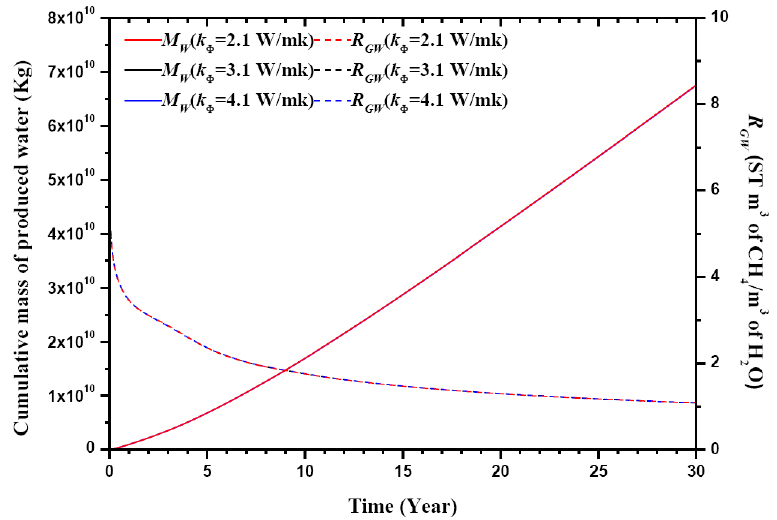
Figure 16. Sensitivity to the thermal conductivity ( k Θ ): evolution of M W and R GW overtime.